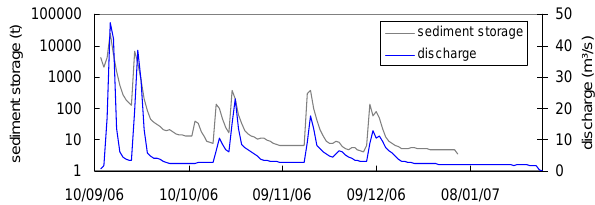
Figure 7: Modelled discharge and sediment storage in the riverbed of the Lower Isábena Fig. 7. Modelled discharge and sediment storage in the riverbed Catchment (2006/09/15-2007/01/29) of the Lower Is´abena catchment (15 September 2006–29 January